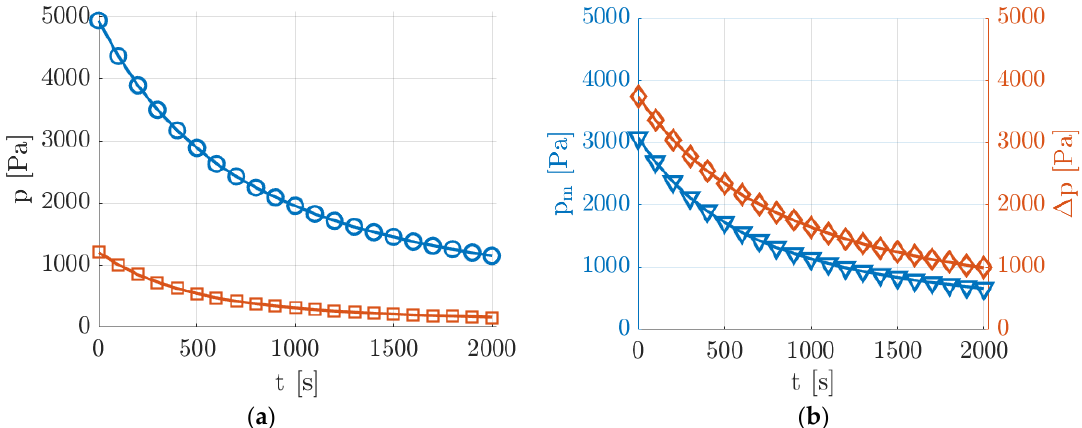
Figure 5. Evolution in time of the experimental pressure conditions generated at low pressures acquired by pressure sensors P1 and P2: ( a ) upstream 𝑝 1 (O) and downstream 𝑝 2 ( ☐ ) pressure measurements and ( b ) mean pressure 𝑝 𝑚 = 𝑝 1 +𝑝 2 ( ▽ ) and pressure difference Δ𝑝 = 𝑝 1 − 𝑝 2 ( ◇ ).